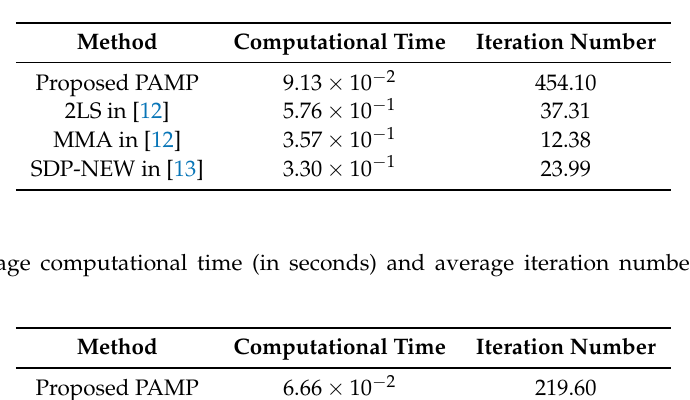
Table 3. Average computational time (in seconds) and average iteration number for the far-field case in scenario 1.